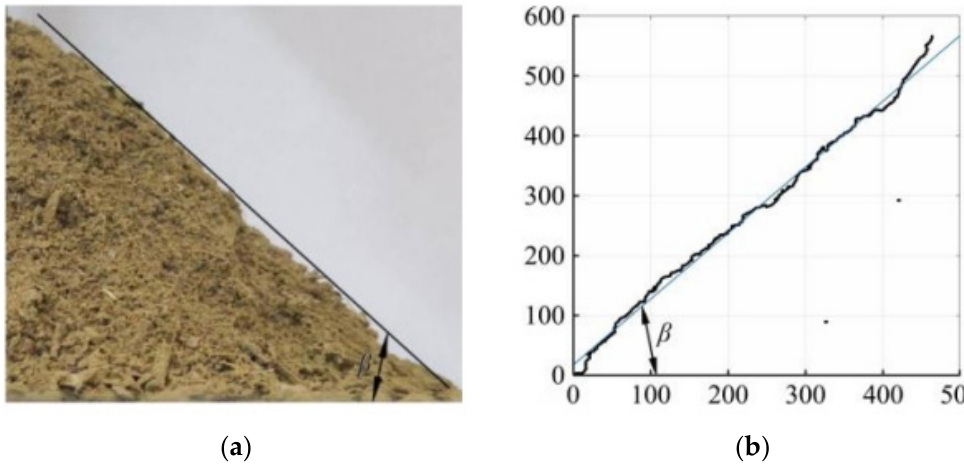
Figure 5. Image information of angle of repose edge and extraction and fitting results. ( a ) Residual film mixture; ( b ) Edge fitting results [64].